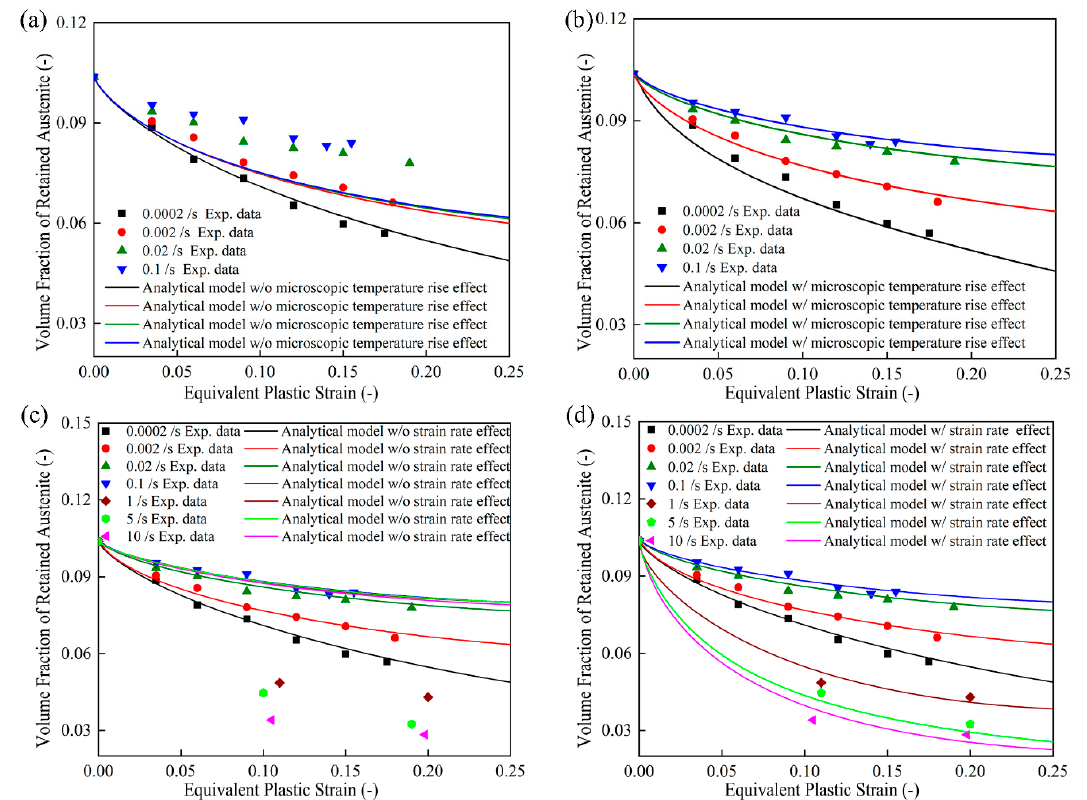
Figure 5. Analytical prediction of temperature and strain rate dependent VFRA: ( a ) taking into account effect of macroscopic temperature rise only; ( b ) taking into account effects of both macroscopic and microscopic temperature rise; ( c ) taking into account effect of temperature rise only; ( d ) taking into account effect of temperature rise and strain